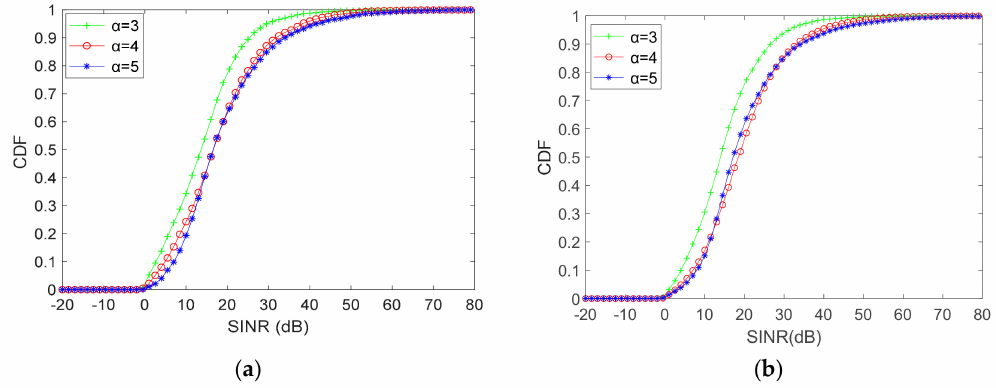
Figure 5. SINR of active D2D pairs for proposed WE-I-A algorithm: ( a ) N = 8, M = 10 and ( b ) N = 16, M = 20.